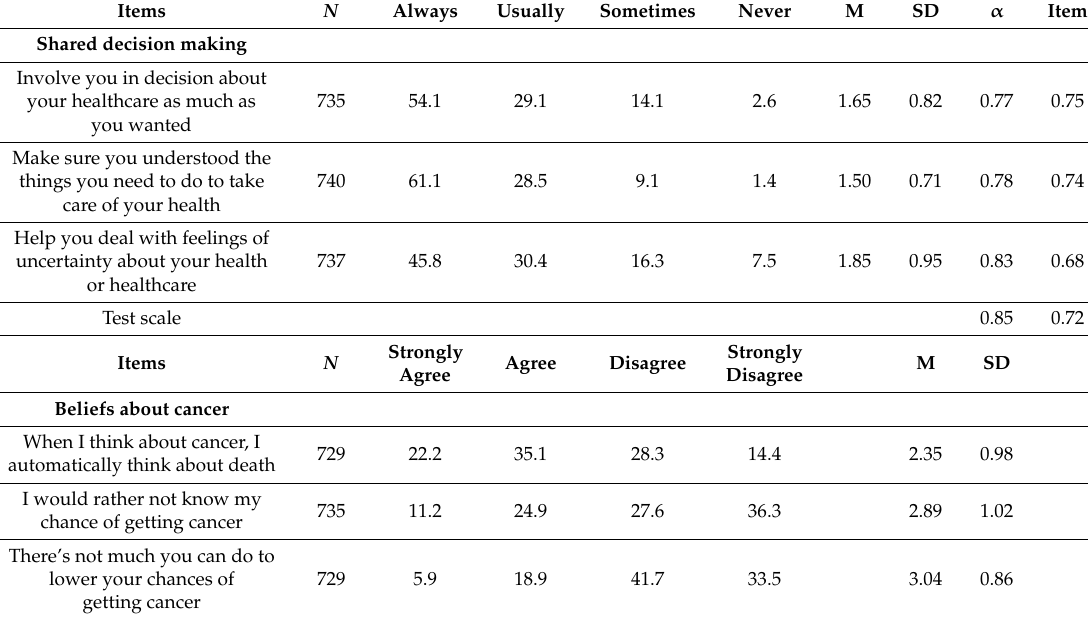
Table 3. Shared decision making and beliefs about cancer items, %.